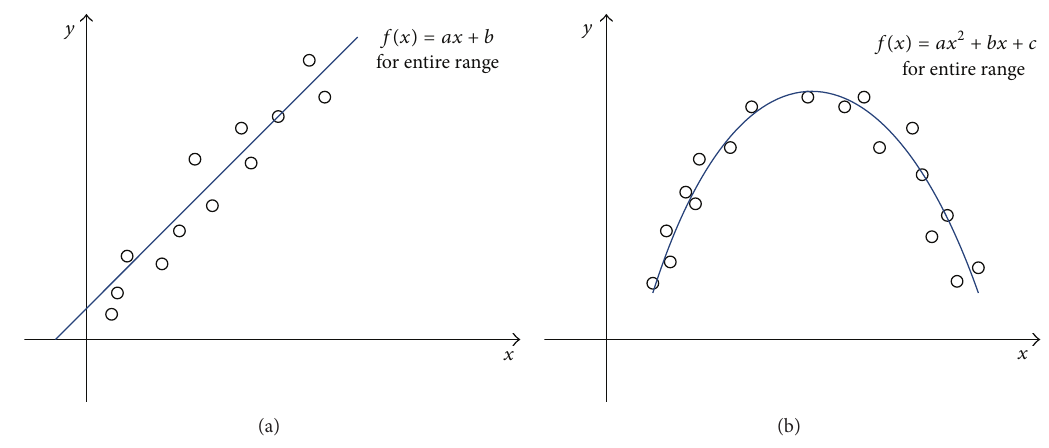
Figure 3: Illustration of the least squares approach (a) linear (b)